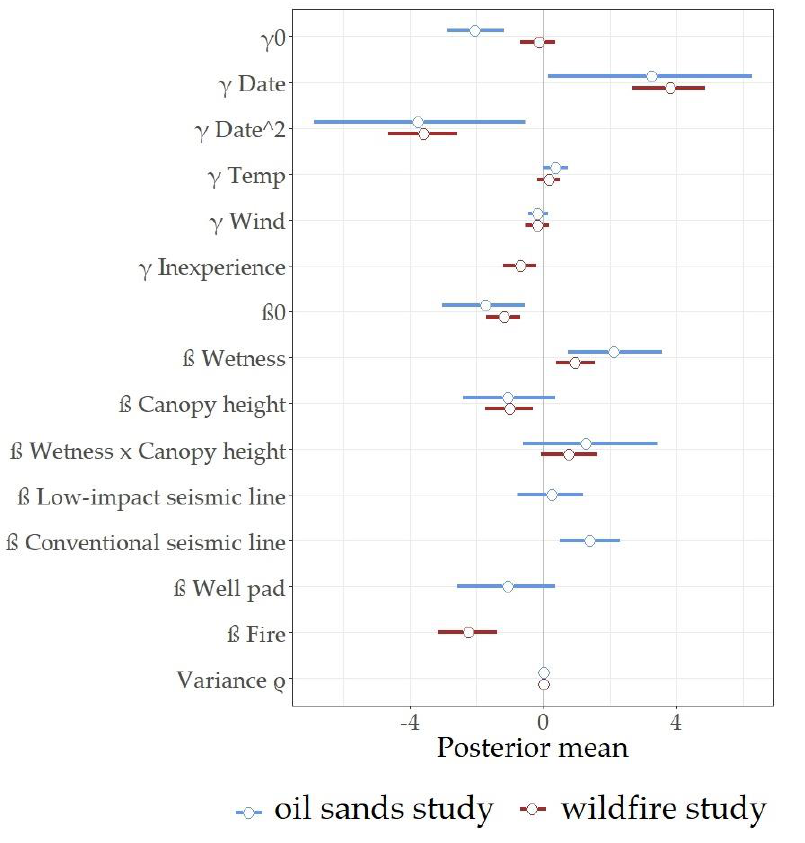
Figure 2. Posterior estimates of the effects of model covariates on cranberry blue detection ( γ coefficients) and abundance ( β coefficients), including a conditional autoregressive component to account for spatial autocorrelation in abundance of cranberry blues between sampling locations closer than 300 m (Variance ρ ). Posterior mean estimates on the left/right side of the zero line (grey) represent negative/positive effects on cranberry abundance.